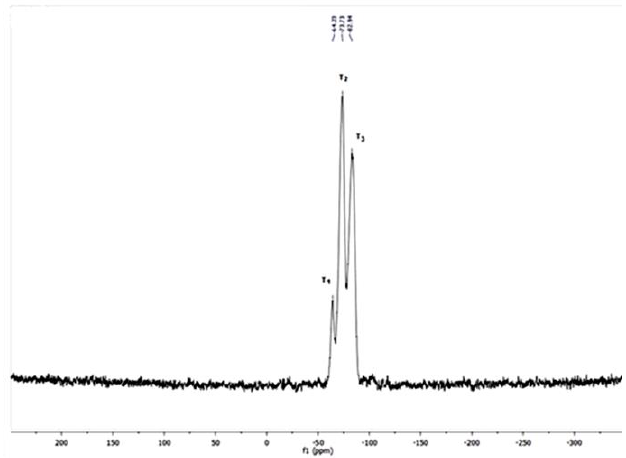
Figure 2. 29 Si CP / MAS nuclear magnetic resonance (NMR) spectrum of the pyridine periodic Figure 2. 29 Si CP/MAS nuclear magnetic resonance (NMR) spectrum of the pyridine periodic mesoporous organosilica (PMO-Py). mesoporous organosilica (PMO-Py).